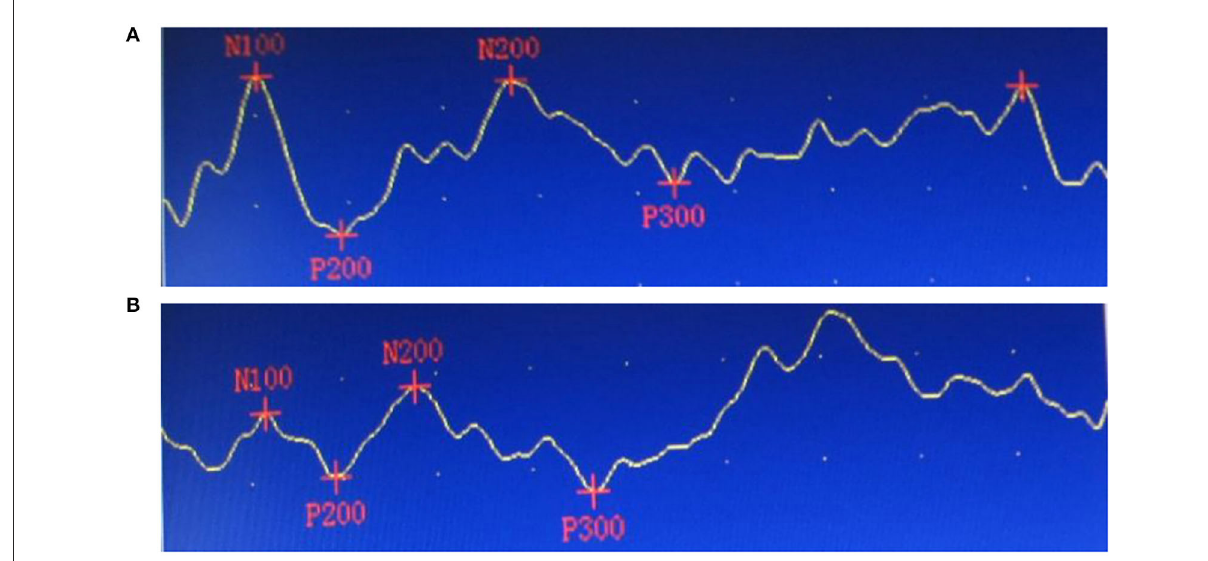
FIGURE3 Event-related potential P300 waves of a 56-year-old patient, before and after repetitive transcranial magnetic stimulation treatment. (A) Before treatment, P300 latency 403.50ms, P300 amplitude 5.97 µ V, Loewenstein Occupational Therapy Cognitive Assessment (LOTCA) total score, 75 points. (B) After treatment, P300 latency 346.50ms, P300 amplitude 11.30 µ V, LOTCA total score, 102